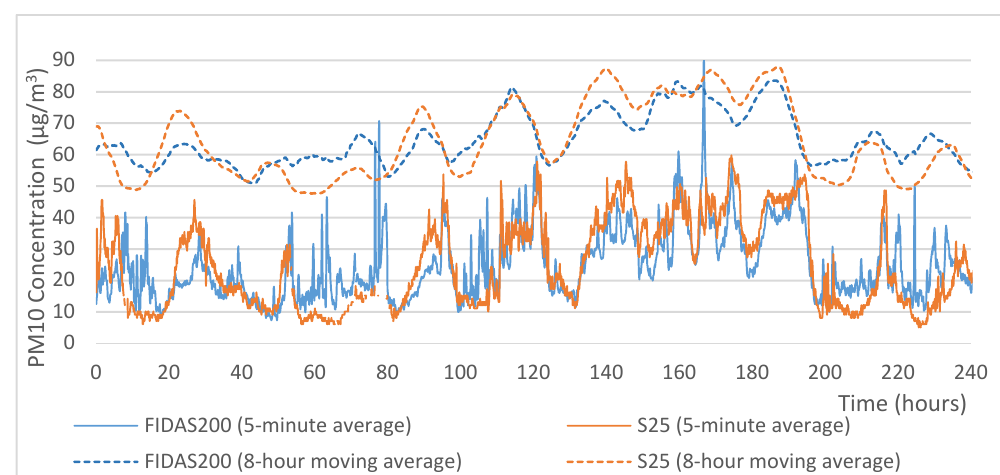
Figure 4. Example of parallel 10-day measurements of PM 10 values measured by a sensor and a reference instrument (FIDAS 200); moving average values were offset by 40 µg/m 3 .